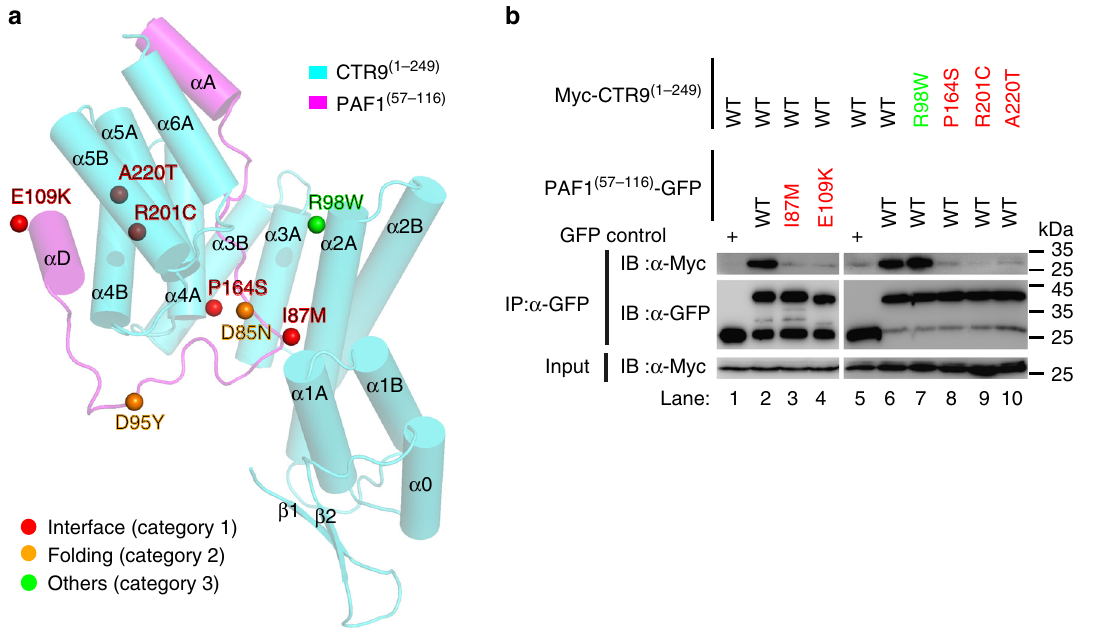
Fig. 3 Disease-associated mutations affect the interaction between CTR9 and PAF1. a Disease-associated mutations in the CTR9 (1 – 129) /PAF1 (57 – 116) complex. For clarify, only fi ve missense-mutation sites in category 1 (interface), two sites in category 2 (folding) of PAF1, and one site (R98W) in category 3 (others) of CTR9 are highlighted with spheres and colored in red, orange, and green, respectively. The full lists of disease-associated mutations in CTR9 and PAF1 are summarized in Supplementary Tables 2 and 3, respectively. b The interaction sites between CTR9 (1 – 249) and PAF1 (57 – 116) containing various disease-associated mutations were evaluated using a co-IP strategy. Myc was tagged to the N-terminal of CTR9 (1 – 249) WT or mutant and GFP was tagged to the C-terminal of PAF1 (57 – 116) WT or mutant. Extracts were prepared from HEK293T cells transfected with various combinations of plasmids, as indicated. The bottom panel shows 3% of the Myc fusion proteins for each IP. Uncropped blots are shown in Supplementary Fig.